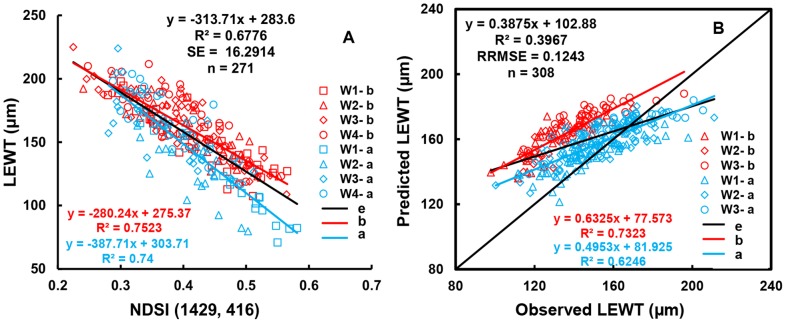
Quantitative relationships between (R1429−R416)/(R1429+R416) and LEWT (A); the 1∶1 relationship between the predicted and observed LEWT on (R1429−R416)/(R1429+R416) in wheat (B).